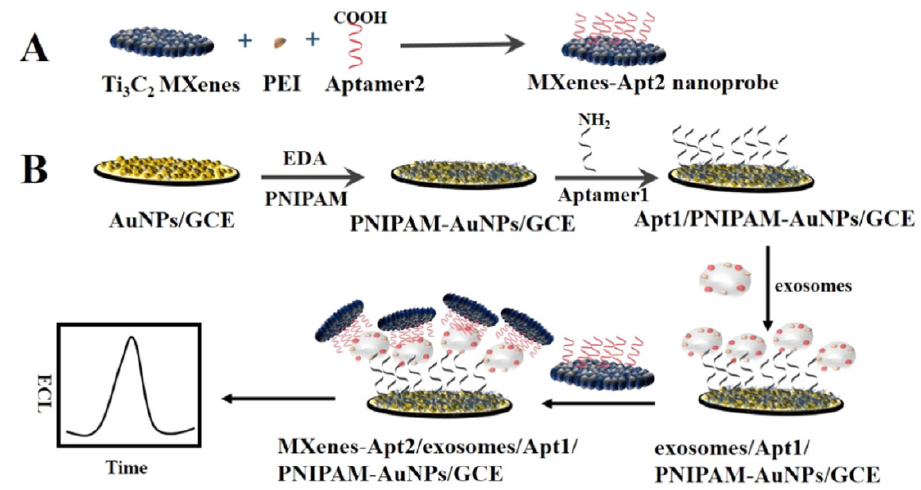
Figure 9. ECL biosensor principle for the signal amplification strategy of exosome activity detection. (Reprinted with permission [207]. © 2018 Elsevier B.V. All rights are reserved.)